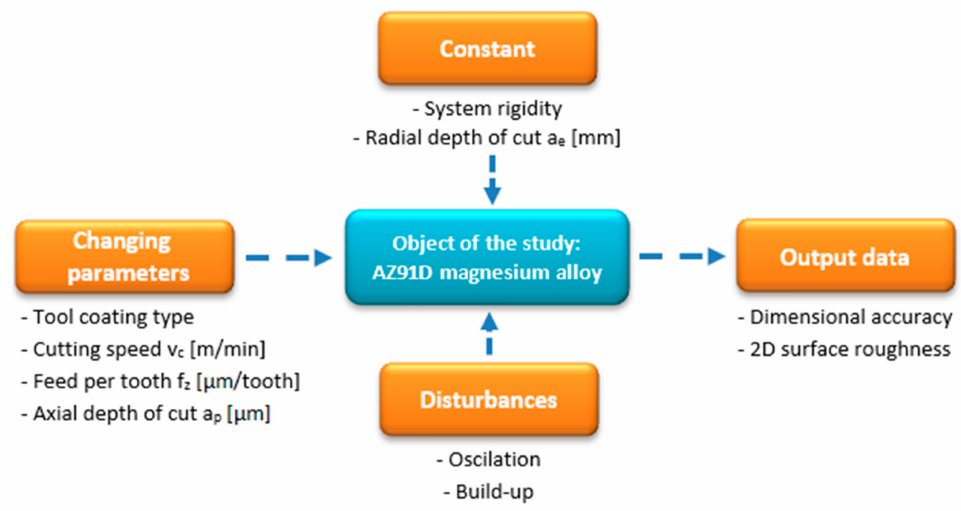
Figure 1. Research plan.